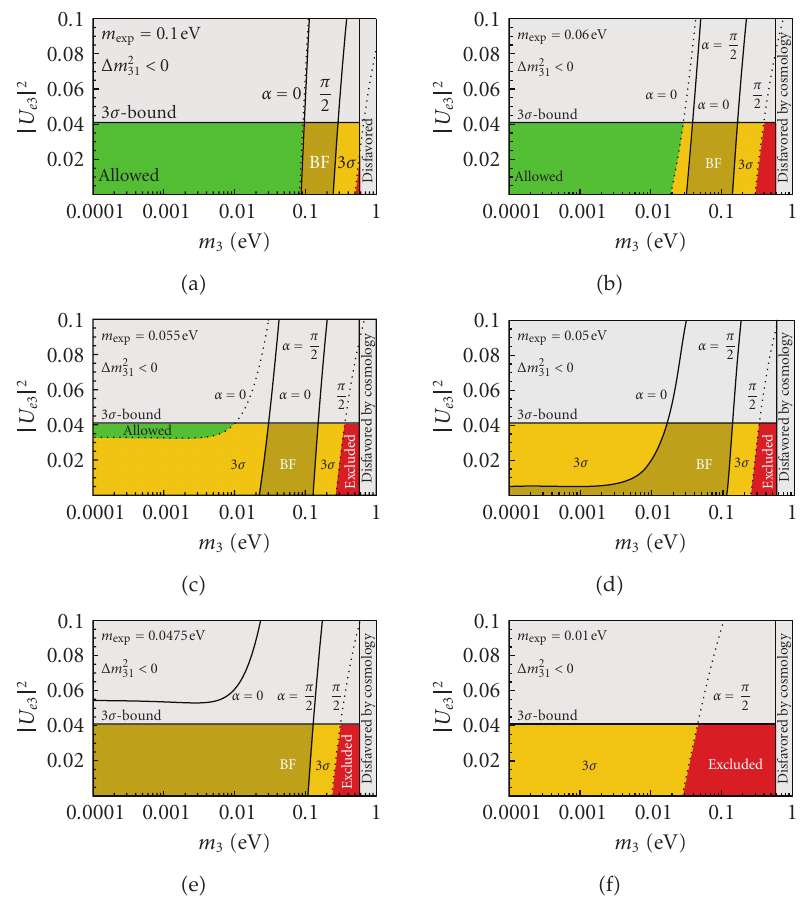
Figure 4: Inverted neutrino mass ordering. Areas in the m 3 - | U e 3 | 2 parameter space in which information from neutrinoless double beta decay experiments could be gained. Di ff erent experimental bounds m exp on the e ff ective mass are shown, as well as the current 3 σ limit on | U e 3 | 2 . The range of the lower limit on | U e 3 | 2 is shown within solid lines in dark yellow for the best-fit values (cid:6) “BF” (cid:7) of the oscillation parameters. The light yellow area within the dotted lines is the lower limit for the 3 σ -ranges. The left and right borders of these areas correspond to α (cid:8) 0 and α (cid:8) π/ 2, respectively. The red areas are excluded, the green areas are